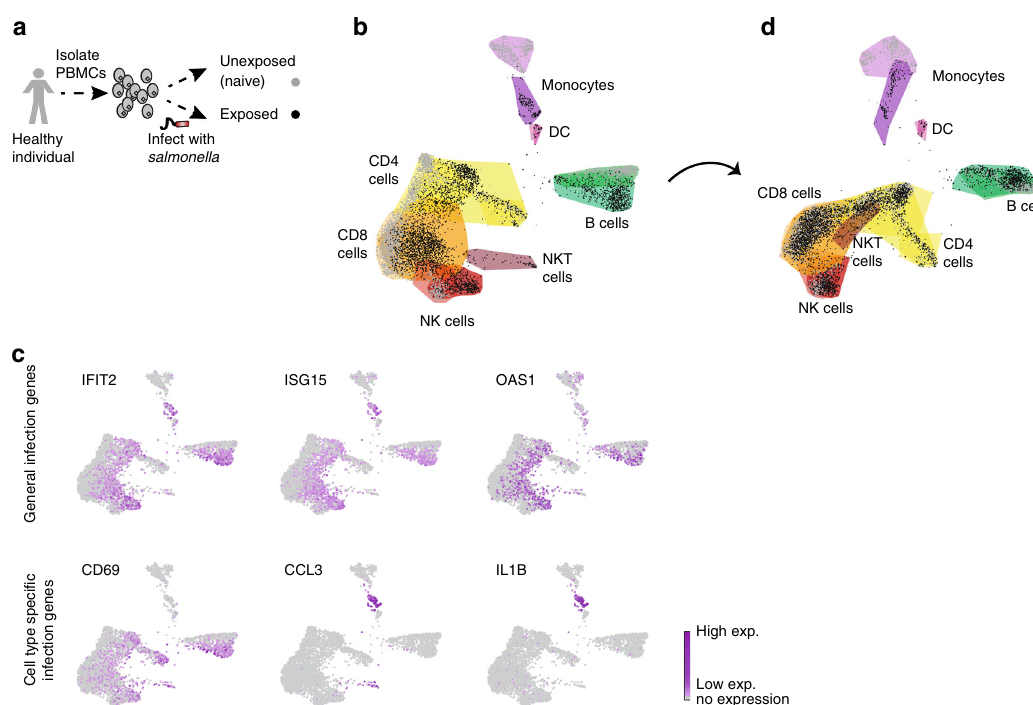
Fig. 1 scRNA-seq analysis of human PBMCs before and after ex vivo Salmonella infection. a Overview of the scRNA-seq experiment: PBMCs were isolated from a blood sample of a healthy individual and were infected ex vivo with Salmonella (exposed), or remained unexposed (naïve). Overall ~7000 cells were sequenced using 10x genomics Chromium. b Visualization of the scRNA-seq data using forced layout on a two-dimensional space by k-nearest neighbor (KNN)-graph ( k = 20; naive cells (gray) and exposed cells (black)). K-means clustering of the cells revealed the seven main cell types: NK cells (red), CD8 T cells (orange), CD4 T cells (yellow), NKT cells (brown), B cells (green), monocytes (purple), and dendritic cells (DC; pink), as inferred using cluster- speci fi c genes and marker genes expression (see Supplementary Data 1 and Supplementary Fig. 3d). Colored contours represent cells which belong to the same cell type in each sample (see also Supplementary Fig. 3a – c for complete KNN-graph with edges and clusters). c Expression levels of representative genes from the infection signature (see methods and Supplementary Fig. 5). Top: general infection genes which are upregulated following Salmonella infection in all exposed cells, and bottom: cell-type speci fi c infection genes. Gene expression is shown using the same layout as in b , with the nodes colored by the indicated gene expression in each cell (see colorbar). d KNN-graph ( k = 20) of the scRNA-seq data after removal of the global infection signature eliminated the separation between naïve and exposed cells for all cell types, except for the monocytes, which contain intracellular bacteria. Colors and contours are the same as in b (see also Supplementary Fig. 3e –